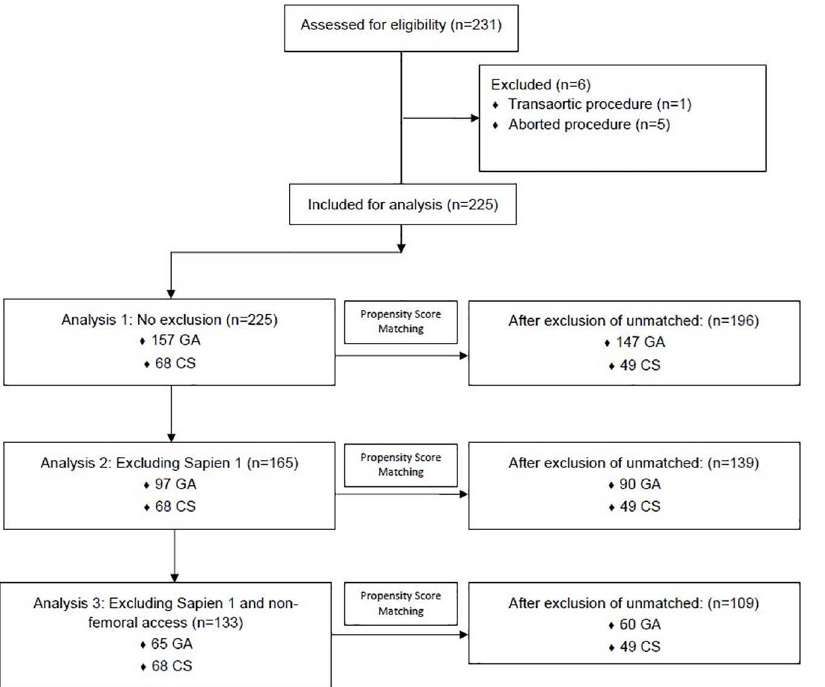
Fig 1. Consort diagram. GA = General Anesthesia group. CS = Conscious